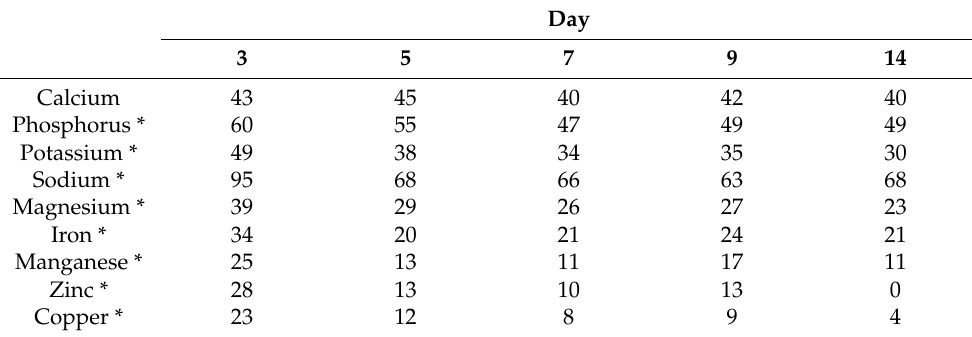
Table 2. Total tract retention (% of intake) of minerals in broilers fed a maize–soybean meal-based diet during the first 14 days